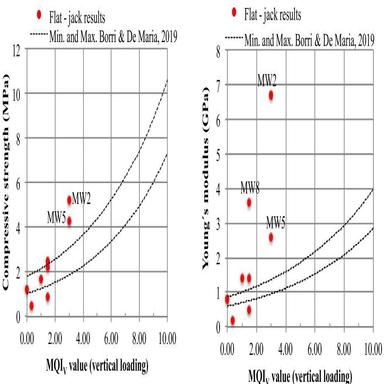
Graphical representation of the trend lines proposed by Borri & De Maria, 2019 for the estimation of masonry's compressive strength (left) and Young's modulus (right), and the results obtained using in-situ flat-jack testing.